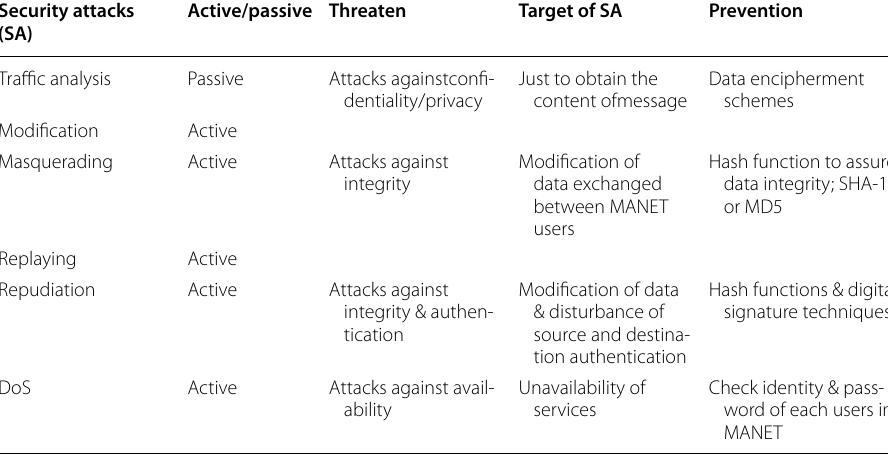
Table 1 Comparative study of various security attacks: target and prevention Security attacks